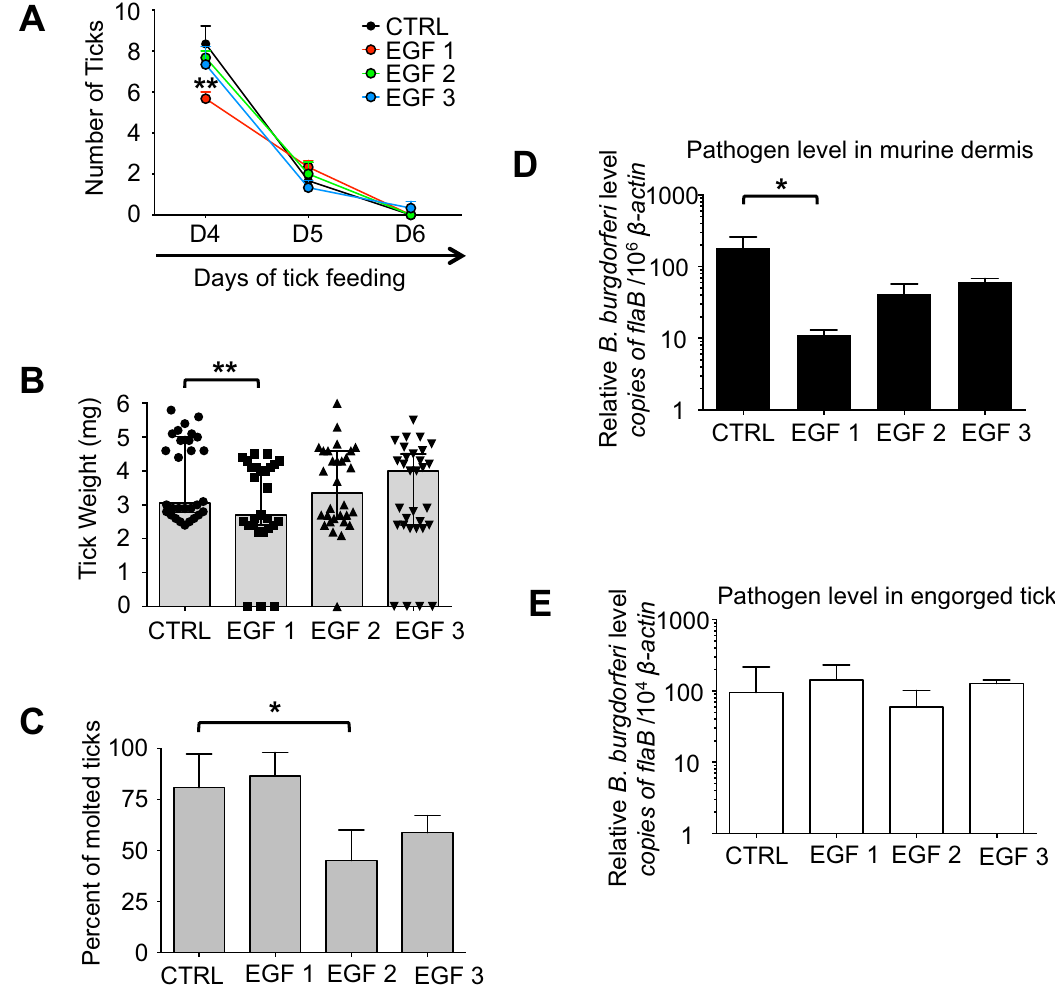
Figure 4. Immunization with EGF domains affects tick feeding and interferes with tick transmission of B. burgdorferi . B. burgdorferi -infected ticks were allowed to feed on mice immunized with Is86 EGF-1, -2, or -3. Ticks that fed on mice immunized with adjuvant only were used as controls. The parameters of tick feeding were recorded. ( A ) Mean number of replete ticks, with error bars showing standard error of mean (± SEM). Fully replete ticks were collected and counted (n = 30, 24, 29, 27/group, respectively). The amount of EGF-1 ticks collected on day 4 was significantly lower (**p < 0.01). ( B ) Median tick engorgement weight, with error bars showing 95% confidence intervals (CI). The weights of individual fully replete ticks (n = 30, 27, 30, 30/group, respectively) were measured. Data points with zero values indicate unattached live or dead ticks collected 24 h post infestation. Fully replete EGF-1 ticks weighed significantly less (**p < 0.01). ( C ) Mean tick molting rate, with error bars showing ± SEM. The collected ticks were allowed to molt (n = 21, 15, 20, 17/group, respectively) in the incubator, and the percentage of molted ticks was calculated. The asterisks indicate statistically significant differences at p < 0.05. ( D ) Mean B. burgdorferi burden in mouse skin. This experiment represents the transmission of spirochetes from infected ticks to naïve mice. Murine skin samples were collected 10 days after tick feeding. Spirochete levels were evaluated by measuring copies of flaB using qPCR and normalizing against mouse β-actin . The B. burgdorferi burden was significantly reduced in mice immunized with EGF-1, as compared to controls (*p < 0.05). Bars represent the mean ± SEM of four qPCR analyses of B. burgdorferi levels from two independent animal experiments. ( E ) Median spirochete burden in ticks (n = 3/group), with error bars showing 95% CI. Spirochete burdens in fully replete ticks were assessed by measuring copies of flaB using qPCR and normalizing against tick β-actin. There was no difference among all EGF domain-immunized and control